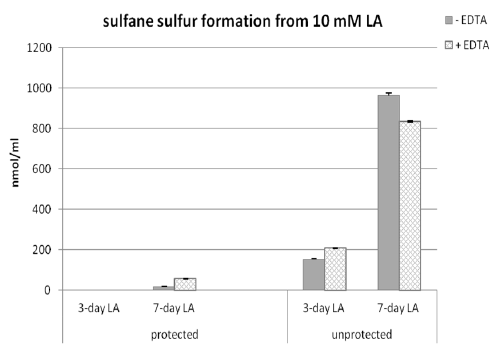
Figure 4. Level of sulfane sulfur formed in vitro non-enzymatically from fresh LA protected from light, and LA left for three or seven days unprotected from light in the presence or absence of ethylenediaminetetraacetic acid (EDTA).